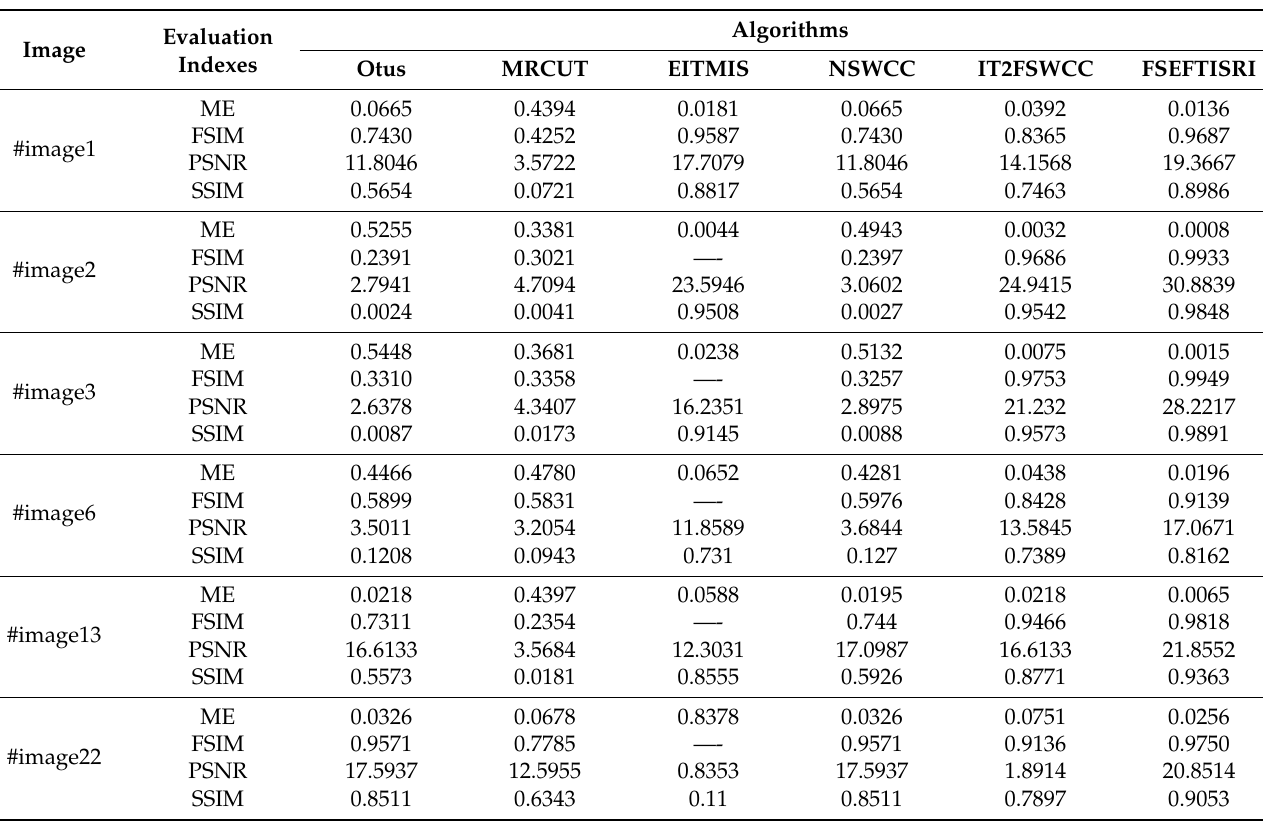
Table 1. Comparison of evaluation indexes of several algorithms in NDT images.